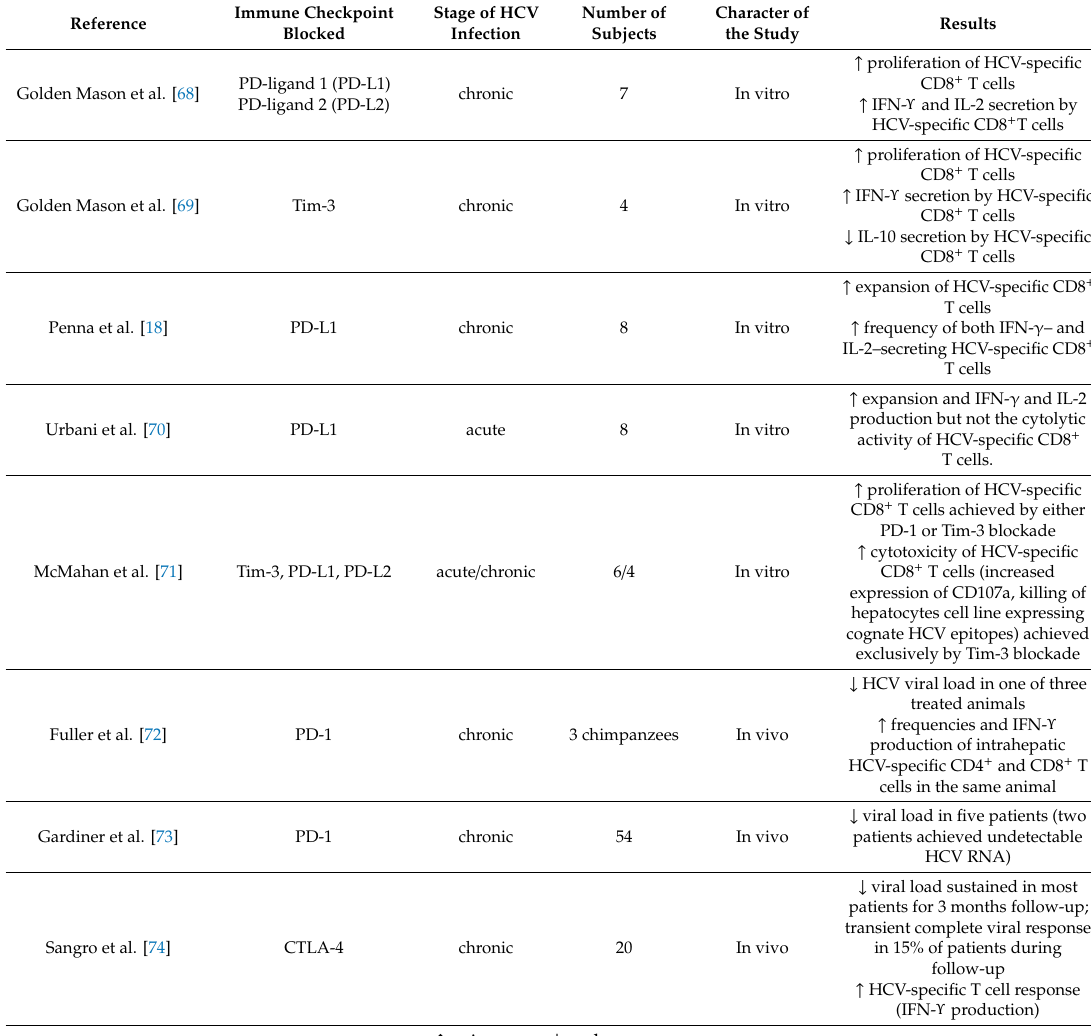
Table 1. Studies reporting the effect of immune checkpoint inhibitor blockades on CD8 + T cell function in HCV infection.